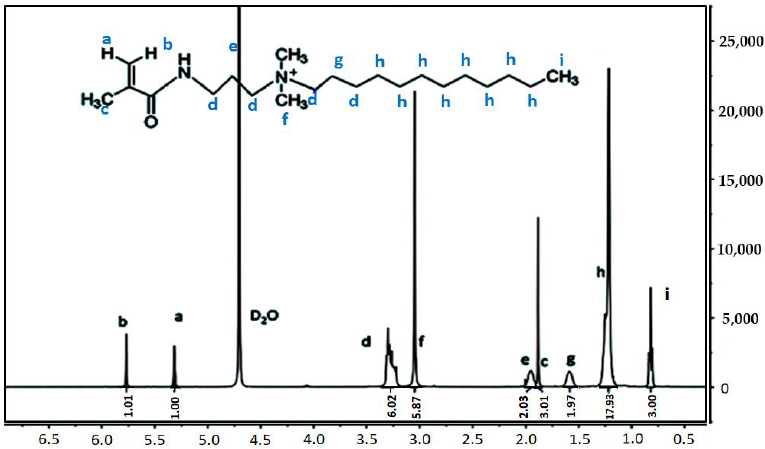
Figure 5. Nuclear magnetic resonance (NMR) profile recorded for CHM.